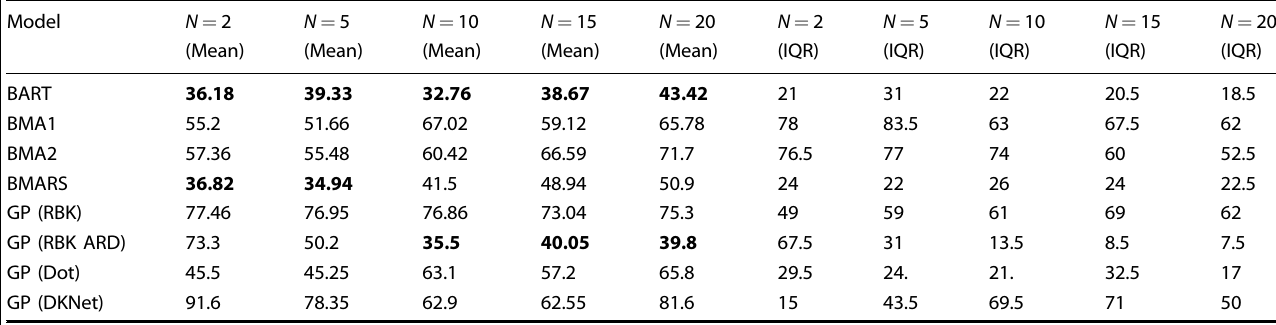
Table 1. The mean value and interquartile range (IQR) of the number of experiments based on each model to fi nd the maximum bulk modulus K in MAX phases with the initial set of sample size N ∈ {2, 5, 10, 15, 20}.